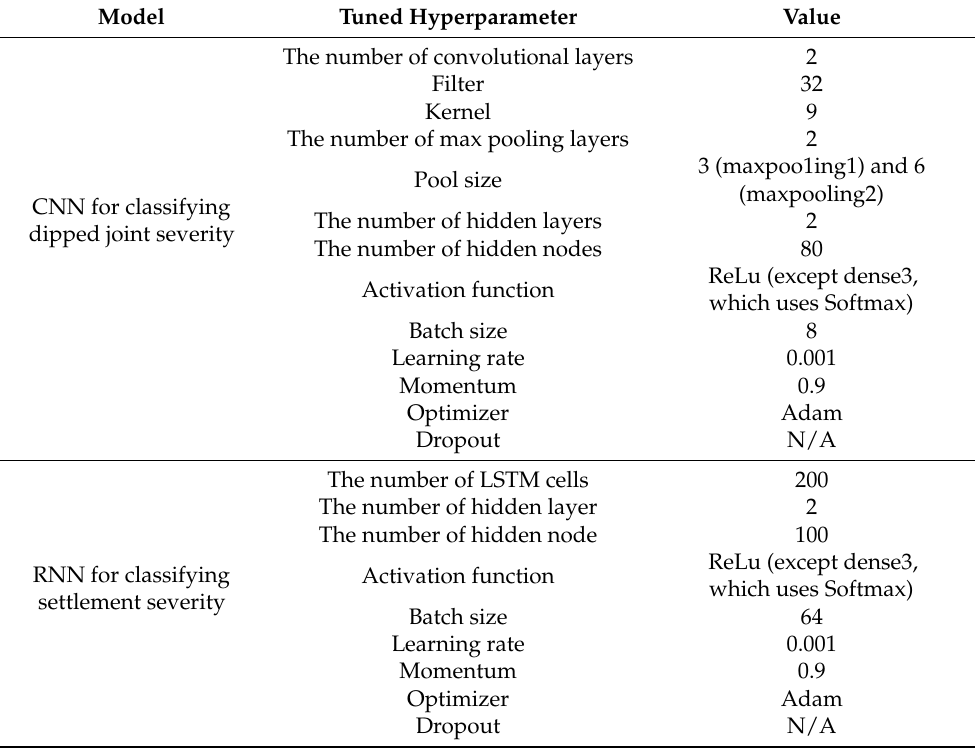
Table 12. List of tuned hyperparameters for classifying the combined detect severity.